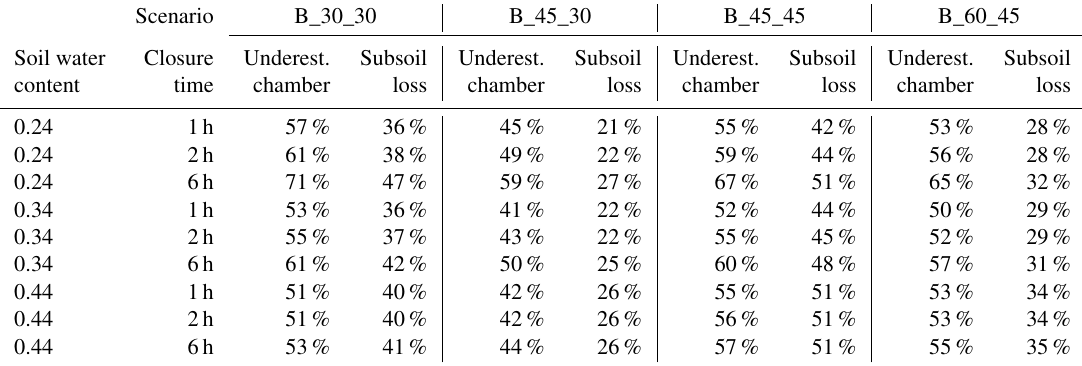
Table 3. Underestimation of N 2 production by chamber measurements using linear regression over time, and mean subsoil loss of N 2 produced within the 15 N-labelled soil. Underestimation and subsoil loss are relative to production rates of the labelled core.